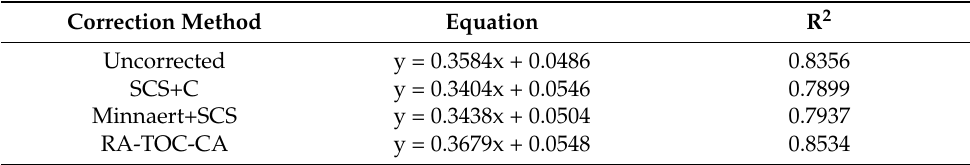
Figure 13. An example of the reflectance of the image and the ground spectra. ( a ) herb, ( b ) shrub, ( c ) tree, ( d ) bare soil.